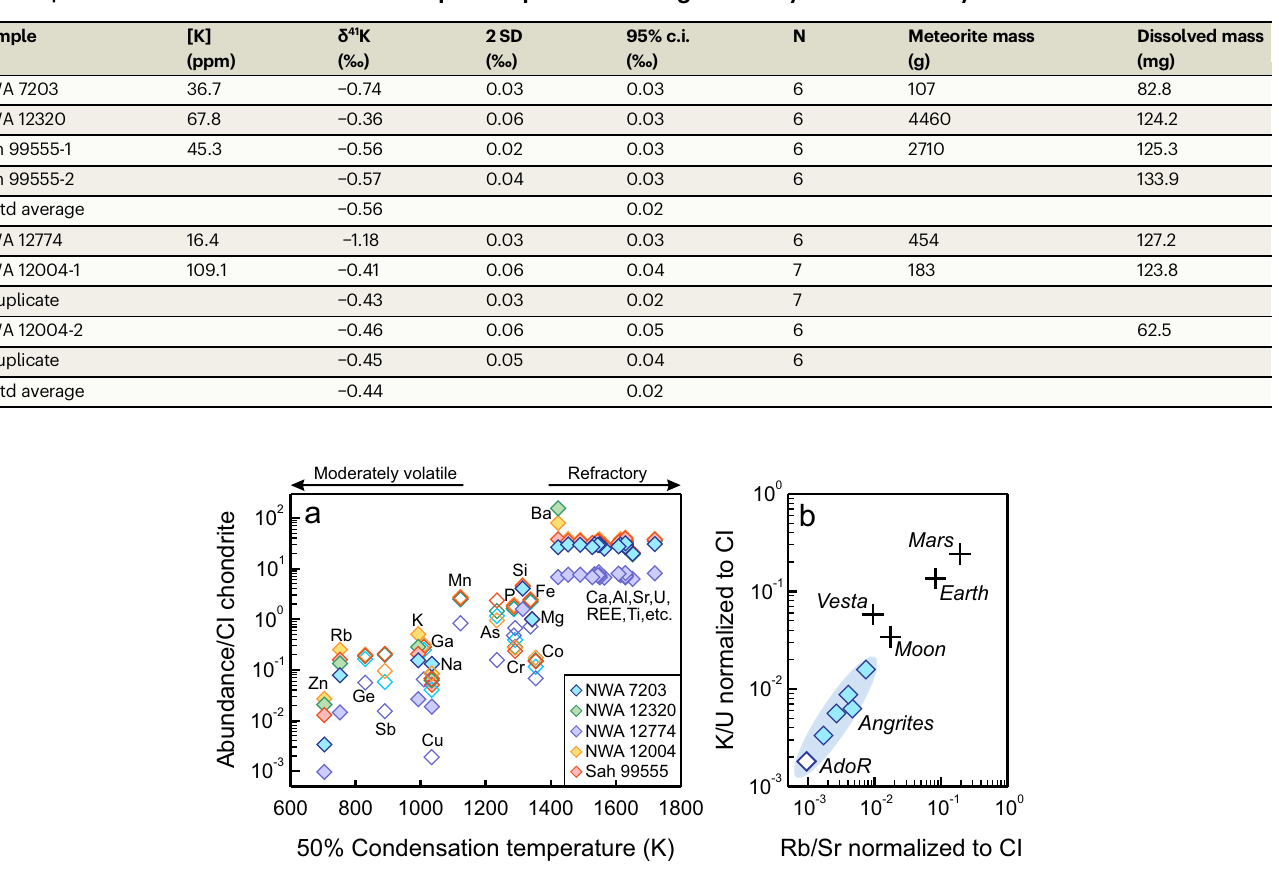
Fig. 1 | Extensive depletionofmoderately volatileelements(MVEs) in angrites. a Elementalconcentrationsofangritesanalyzedinthisstudyareplottedrelativeto concentrations in CI chondrites 45 (both are normalized to Mg=1.0) versus 50% nebular condensation temperatures 57 . Lithophile elements are shown in solid symbols and siderophile elements are shown in open symbols. REE refers to rare